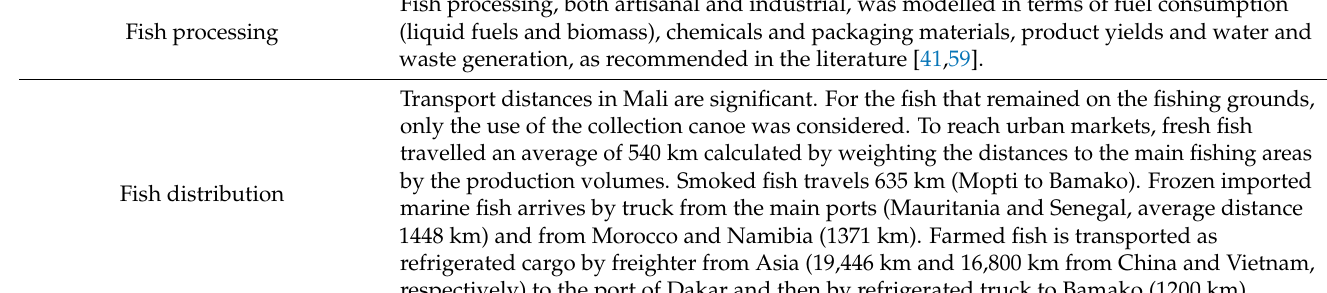
Table 2. Life cycle inventories by the type of unit of production of the Malian fisheries value chain. Unit of Production (UP) Type Life Cycle Inventory Items